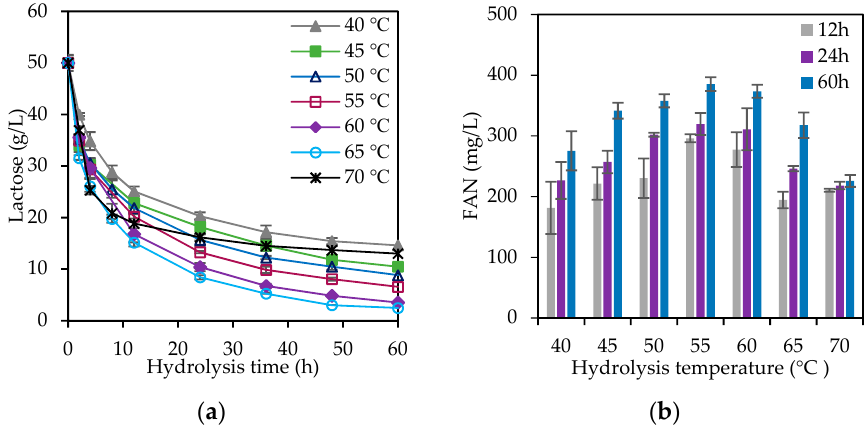
Figure 3. Effect of temperature on cheese whey (CW) hydrolysis using crude β -galactosidase and proteases. Kinetics of ( a ) lactose hydrolysis and ( b ) free amino nitrogen (FAN) production.